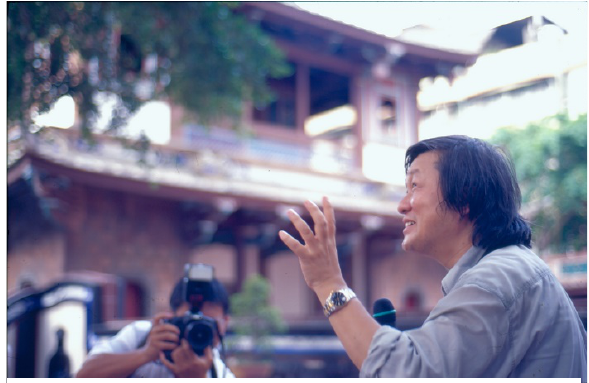
Figure 1: Professor Gan-Lang Li.